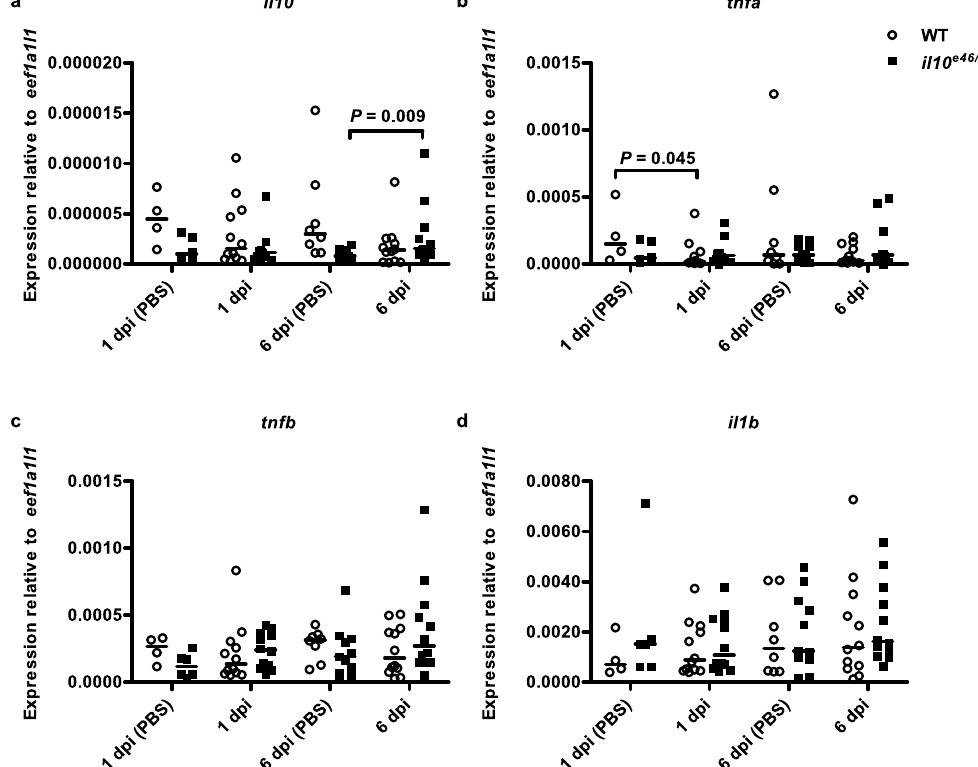
Figure 4. Nonfunctional il10 does not increase the expression of proinflammatory cytokines at the early stages of a low-dose (2–9 CFU) mycobacterial infection in zebrafish. ( a–d ) The relative expression levels of il10 and proinflammatory cytokine genes ( il1b , tnfa and tnfb ) were measured in the abdominal organ blocks (including kidney) of il10 e46/e46 mutant fish ( n = 6–12) and WT controls ( n = 5–12) at 1 dpi and 6 dpi and are presented as a scatter dot plot and median. Note the different scales of the y axes. Gene expressions were normalized to the expression of eef1a1l1 . The data were collected from a single experiment. A two-tailed Mann-Whitney test was used for the statistical comparison of